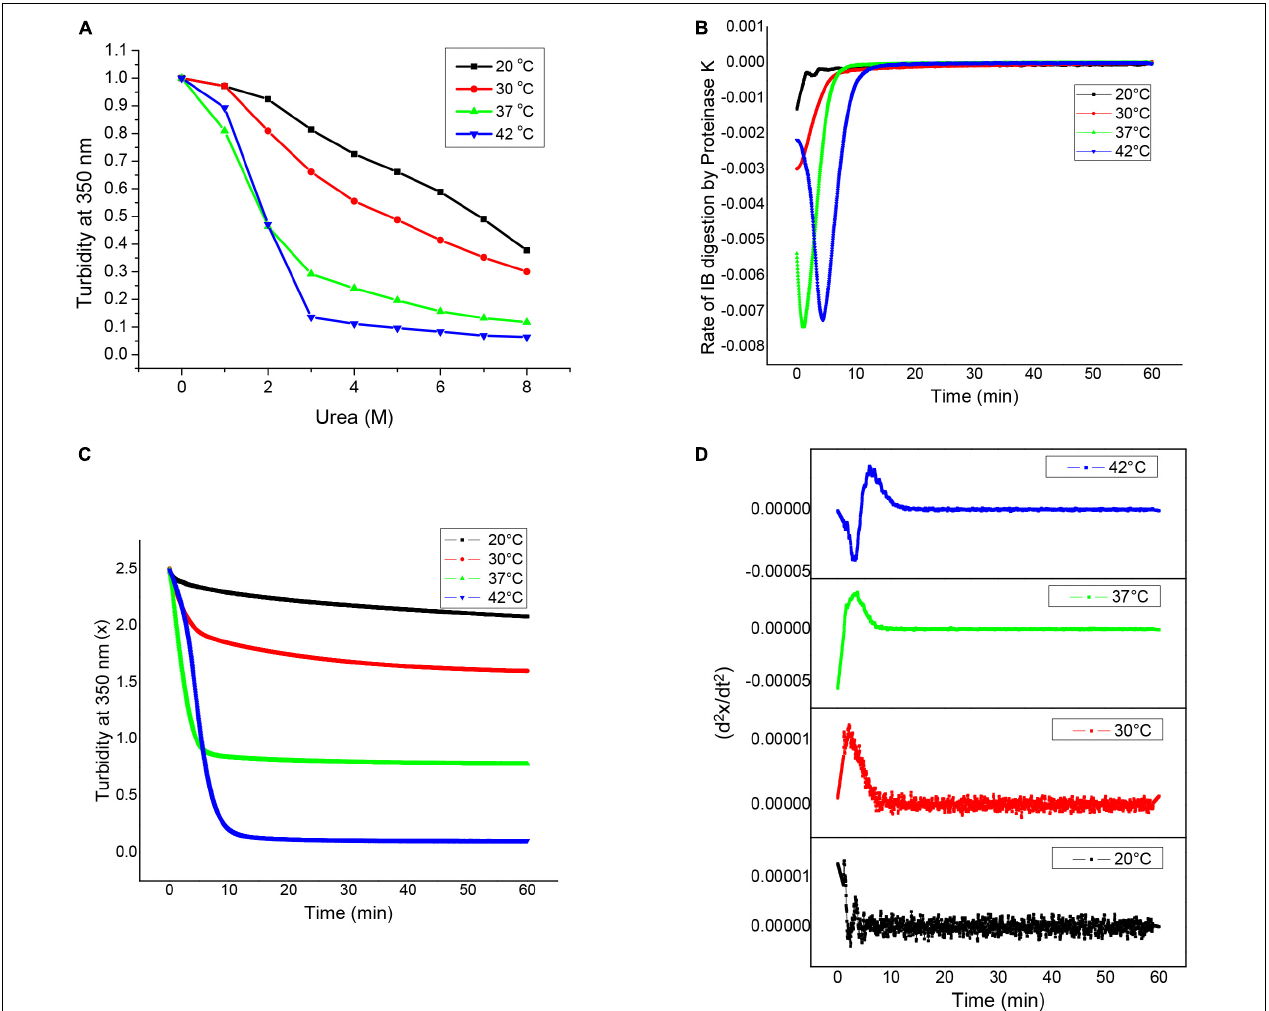
FIGURE 4 | Structural analyses of asparaginase inclusion bodies as a function of induction temperature. (A) Urea solubilization profiles for asparaginase inclusion bodies expressed at different temperatures. (B) Proteinase K digestion profiles of asparaginase inclusion bodies expressed at different temperatures. (C) Rates of inclusion body digestion with respect to time for different asparaginase inclusion bodies. These rates were obtained by differentiating the data represented in (B) with respect to time. (D) Double differential of turbidity at 350 nm with respect to time (d 2 x/dt 2 ) for asparaginase inclusion bodies.